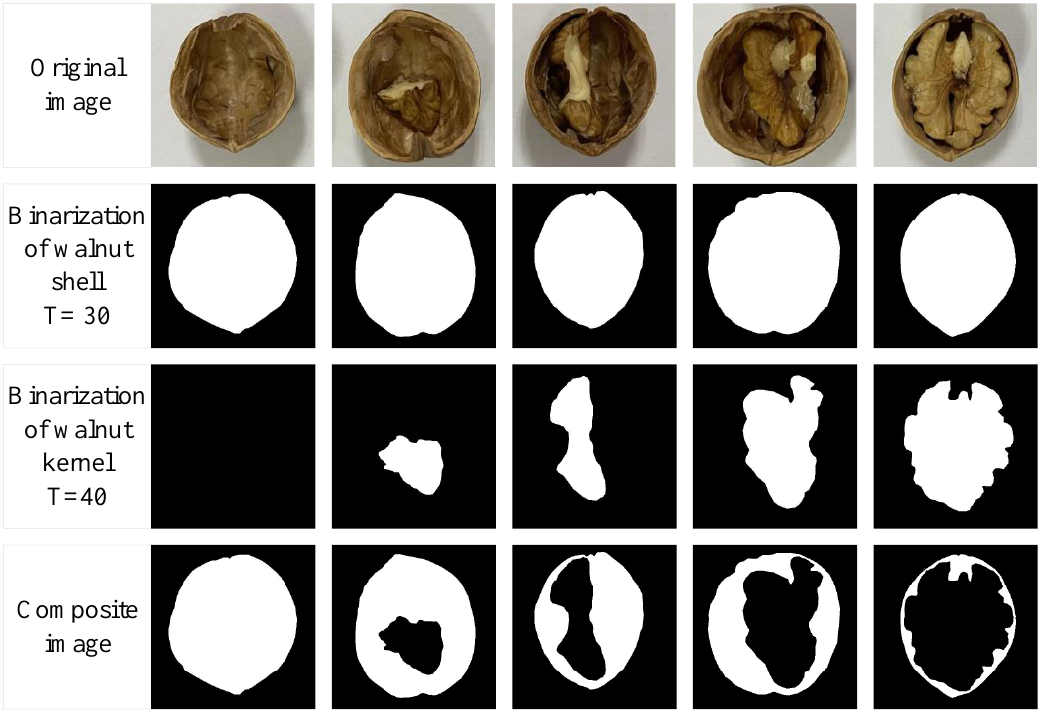
Figure 10. Original image processing flow of five types of samples with different plumpness.